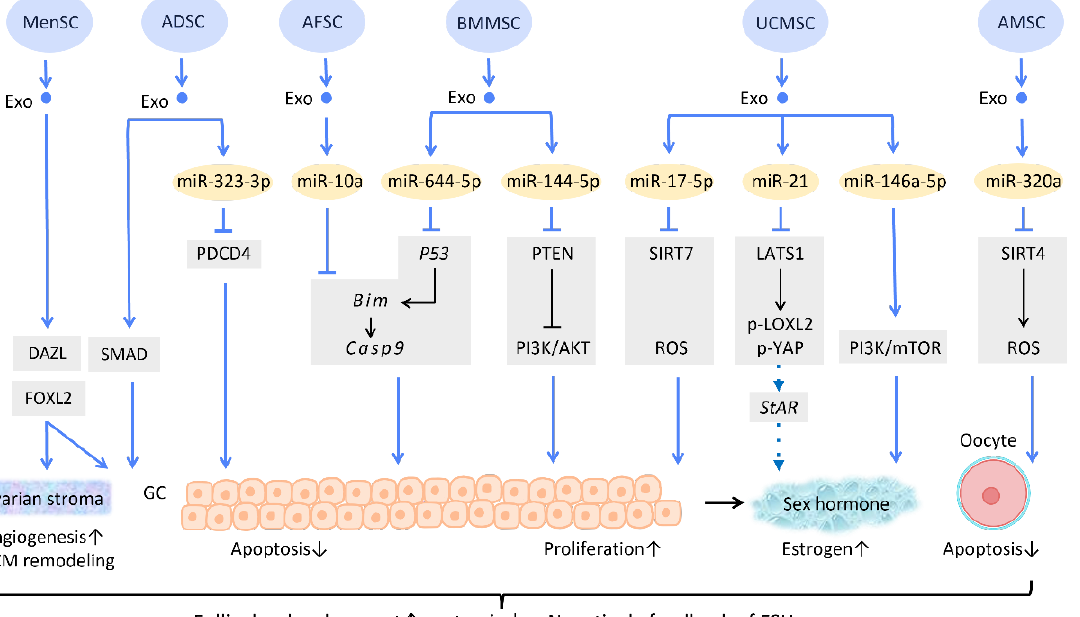
Figure 5. Molecular mechanisms of stem cell-derived exosomes in follicular development. Follicular malfunction is the critical reason of ovarian reproductive disorders. With the help of stem cell-derived exosomes, follicular growth and sex hormone levels could be restored, and ovarian microenvironment could be rejuvenated. Abbreviation: Exo: exosome; SC: stem cell/stromal cell; MSC: mesenchymal stem cell; MenSC: menstrual blood-derived SC; ADSC: adipose-derived stem cell; AFSC: amniotic fluid stem cell-derived; BMMSC: bone marrow-derived MSC; UCMSC: umbilical cord MSC; AMSC: amniotic MSC; miR: micro-RNA; DAZL: deleted in azoospermia like; FOXL2: forkhead box L2; PDCD4: programmed cell death protein 4; PI3K/Akt: phosphatidyl-inositol 3-kinase/serine-threonine kinase; SIRT: sirtuin; ROS: reactive oxygen species; LATS1: large tumor suppressor 1; LOXL2: lysyl oxidase-like 2; YAP: Yes-associated protein; StAR: steroidogenic acute regulatory gene; GC: granulosa cell; ECM: extracellular matrix. ↑ represents upregulation; ↓ represents downregulation.